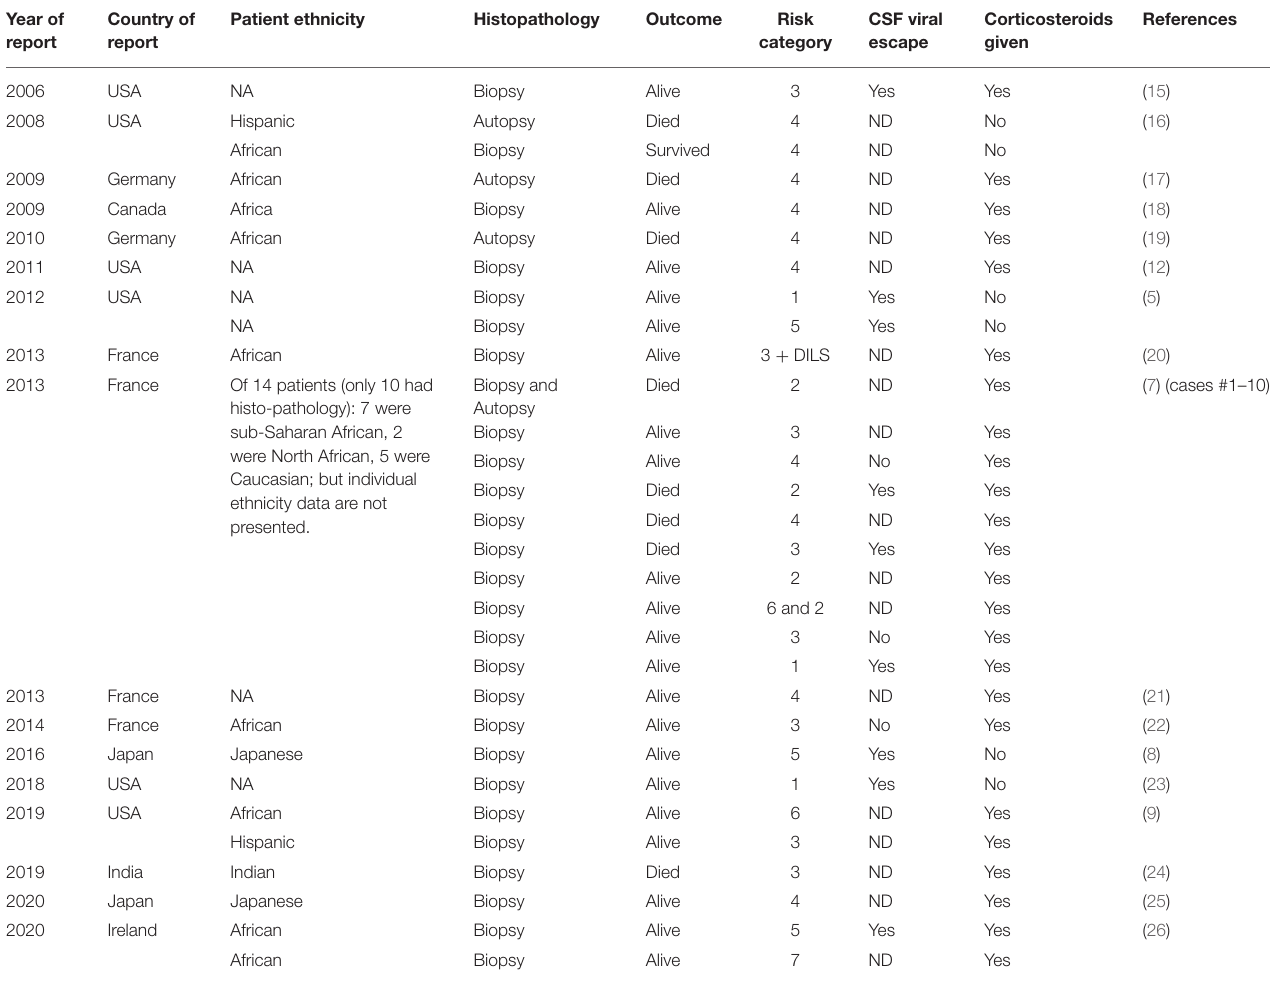
TABLE 2 | Previously published non-UK (global) histopathologically-confirmed cases of HIV-associated CD8 encephalitis. Year of Country of report